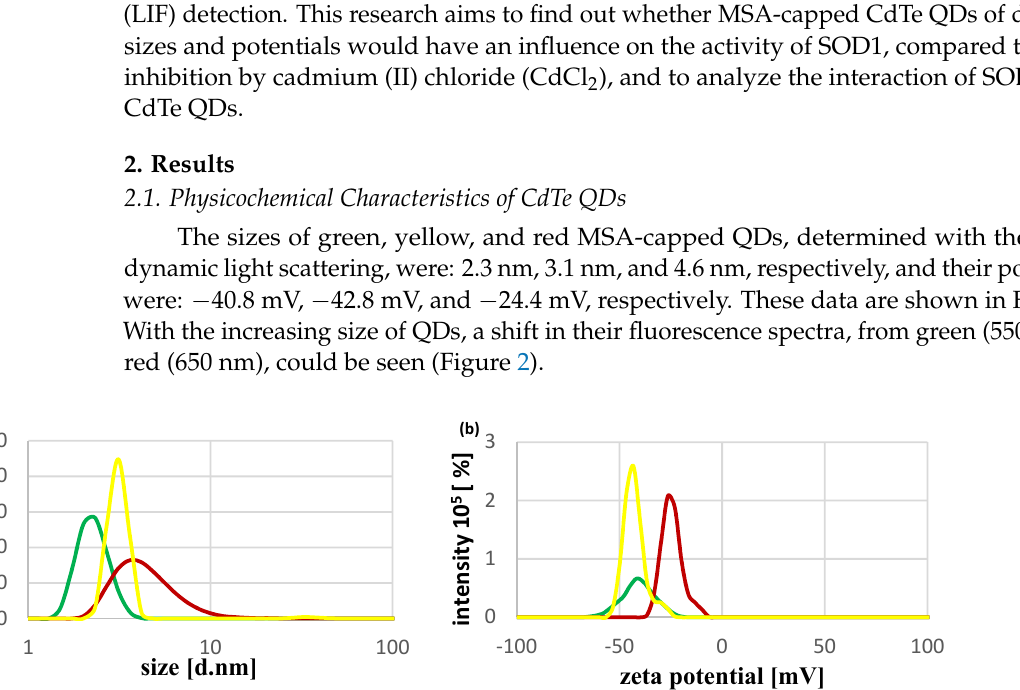
Figure 1 . Size ( a ) and zeta potential ( b ) of green, yellow, and red MSA-capped CdTe QDs. The colors in the chart correspond to the colors of the QDs. (a) Logarithmic scale is used on the x-axis.